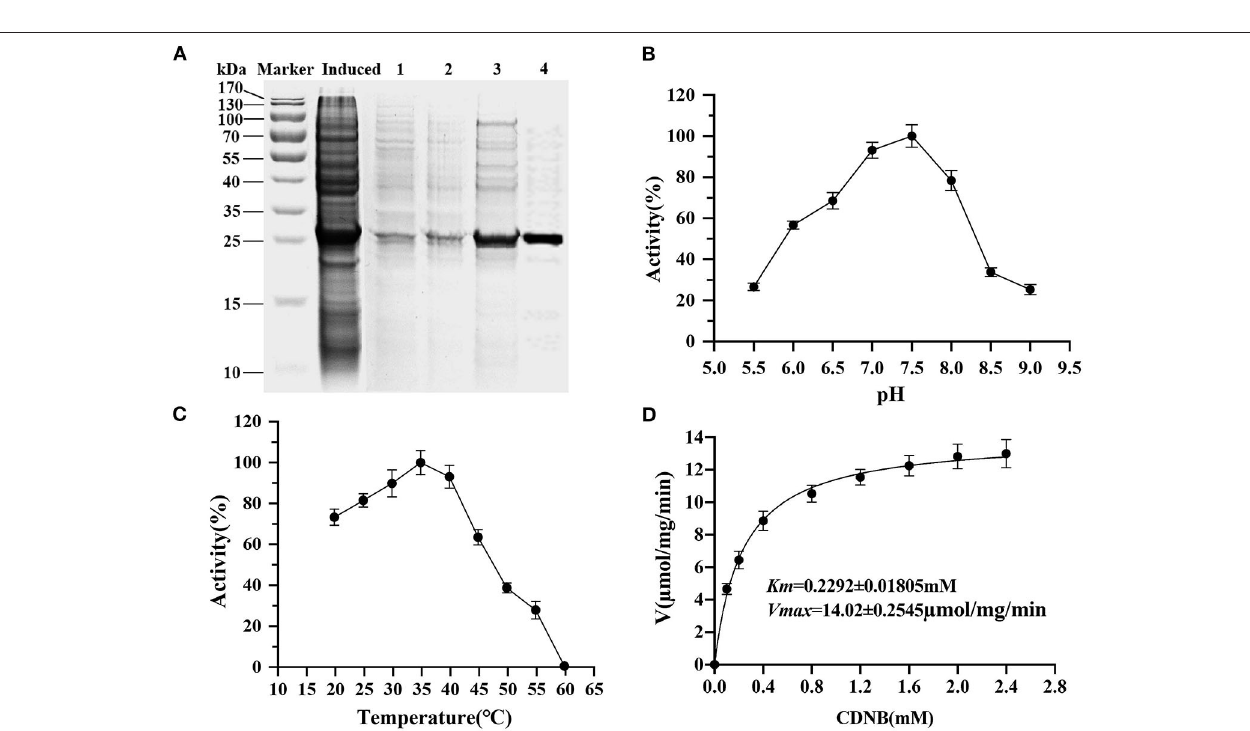
FIGURE 5 | Kinetic properties of recombinant PiGSTd1. (A) Purification of recombinant pEasy-Blunt-E1-PiGSTd1. Induced: the crude extracts from the bacterial pellets with 1mM isopropyl β -D-1-thiogalactopyranoside (IPTG) induction. 1–4: samples eluted with binding buffers containing 50, 100, 150, and 200mM imidazole, respectively. (B) Enzyme kinetic of PiGSTd1 with different CDNB concentrations and a fixed GSH concentration. (C) Optimal pH of PiGSTd1 assayed using 100mM acetate-phosphate buffer at varying pH. (D) The catalytic activity of PiGSTd1 was determined by preincubating enzyme solution at different